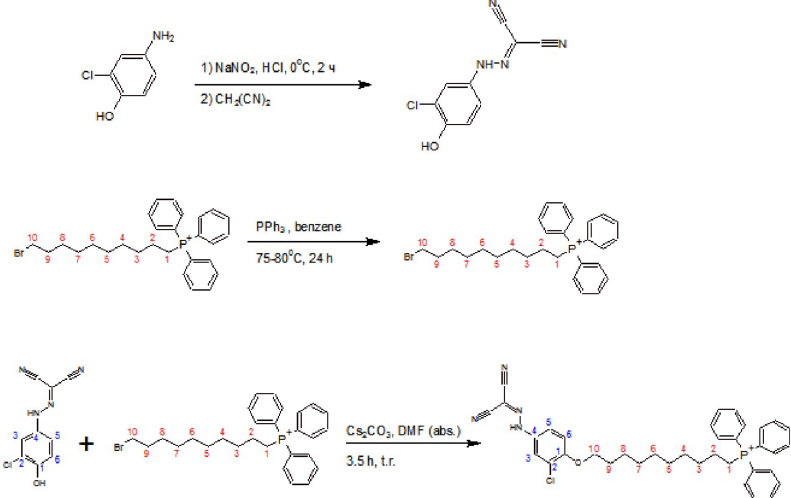
Fig 1. A scheme of the synthesis of mitoCCCP, a derivative of the protonophore CCCP (carbonyl cyanide m - chlorophenylhydrazone) targeted to mitochondria by a decyl(triphenyl)phosphonium